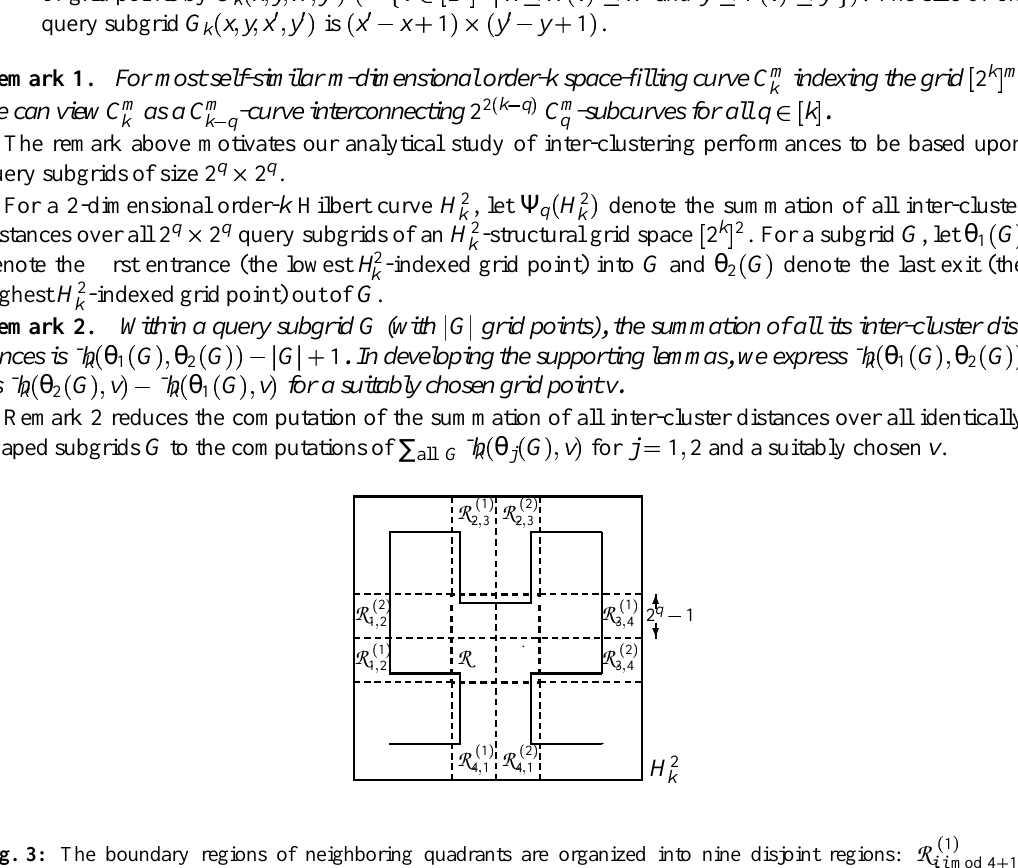
Fig. 3: The boundary regions of neighboring quadrants are organized into nine disjoint regions: R 2 R (cid:13) i i mod 4 (cid:21) 1 (cid:12) (cid:14)